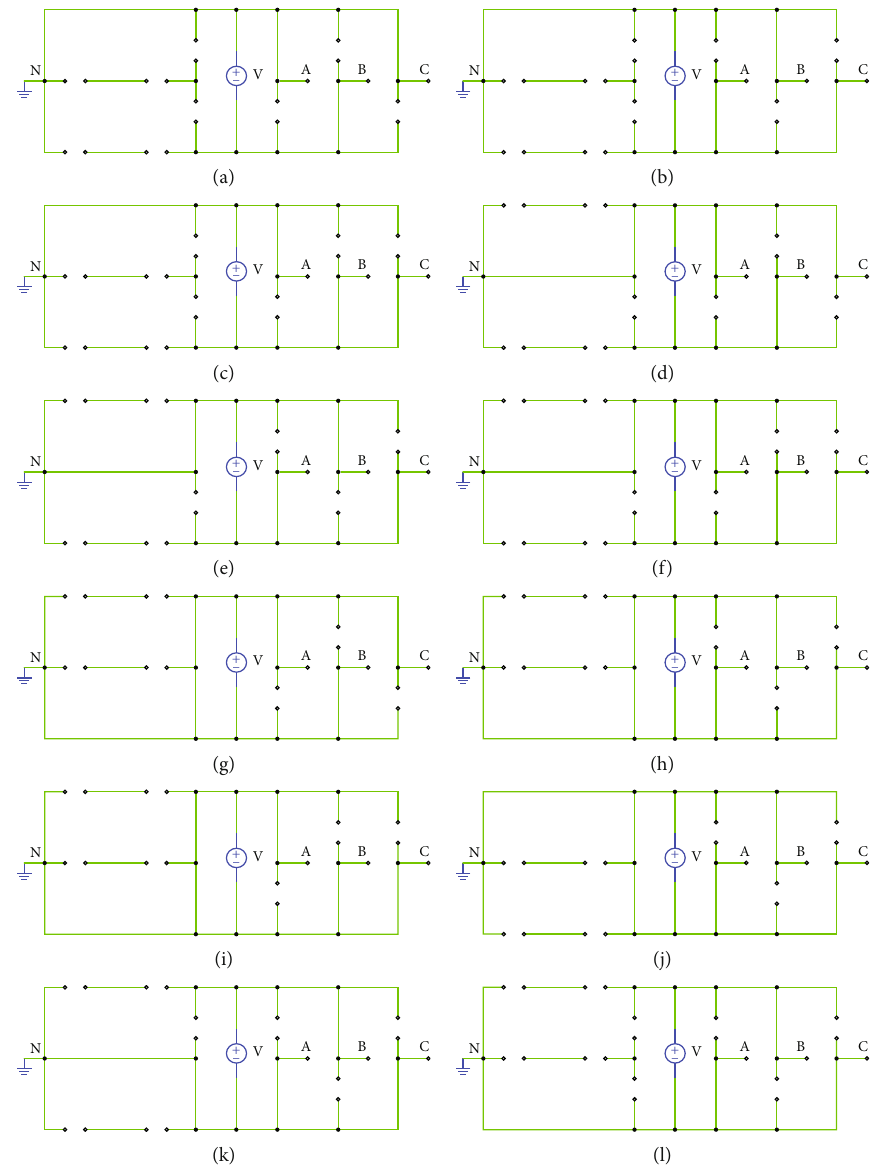
Figure 5: Some combinations that can be made by the